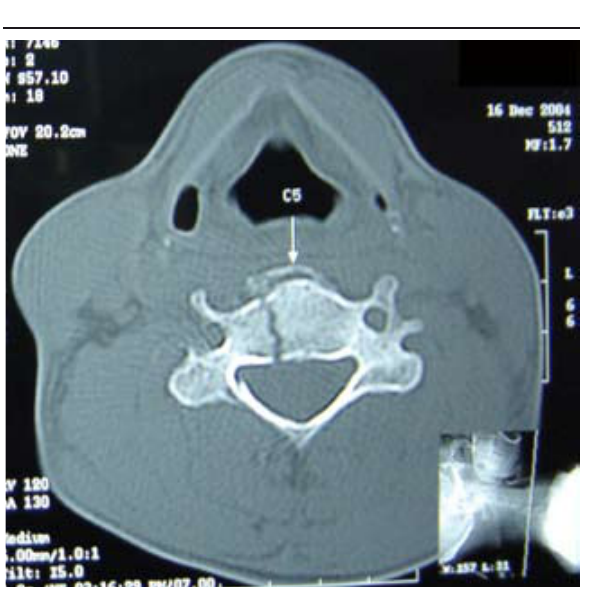
Figure-2.Ct scan cervical spine showing fracture of C-5 vertebral